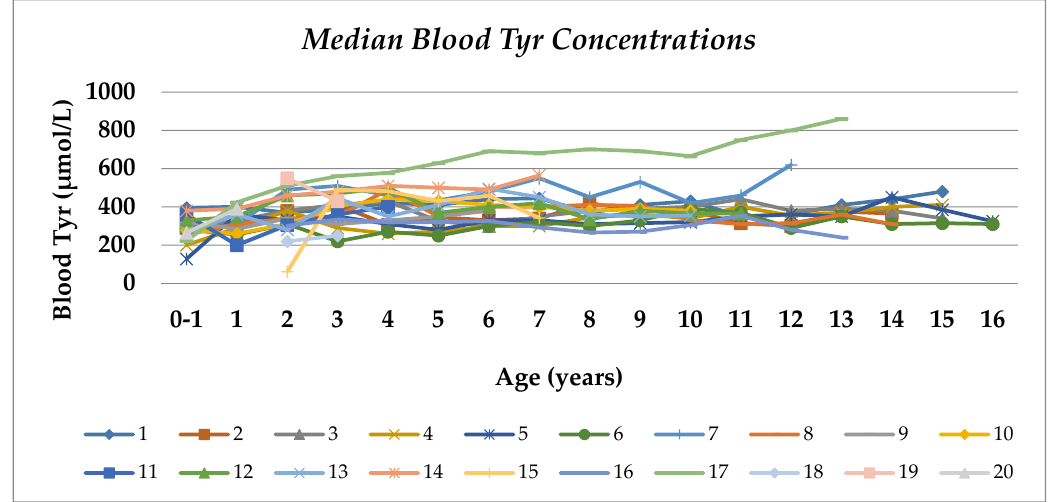
Figure 1. Median blood Tyr concentrations by age in patients with HTI. Coloured lines represent individual patients.